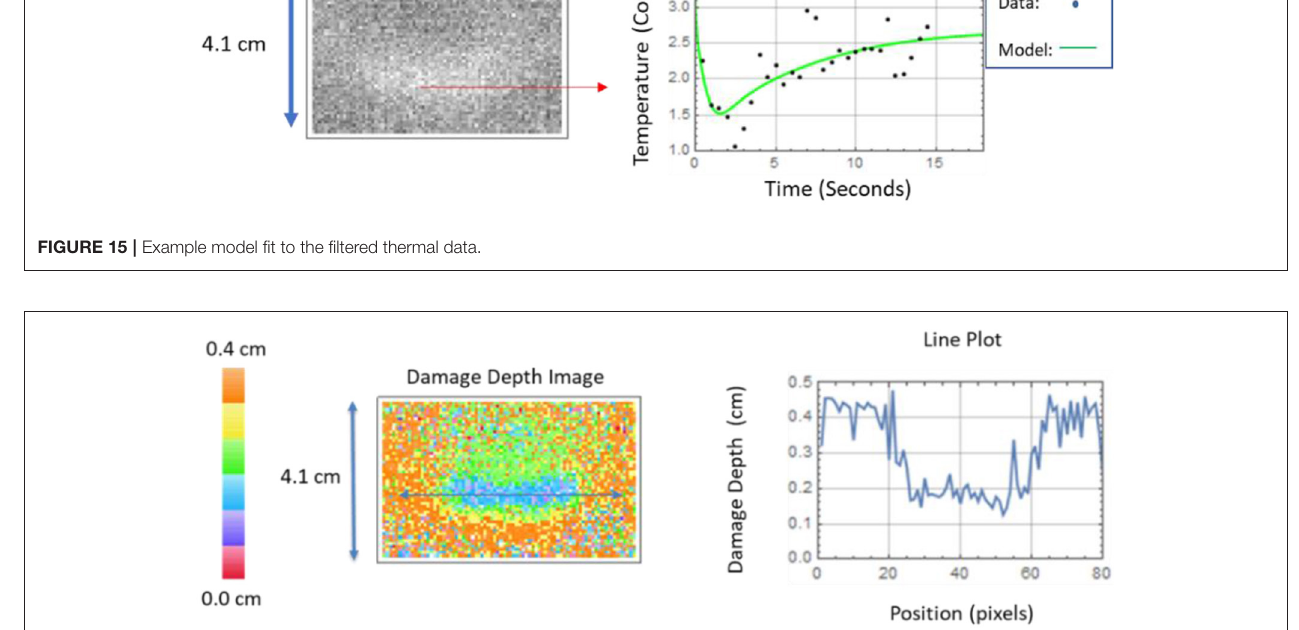
FIGURE 16 | Model fit damage depth image with line plot showing damage depth